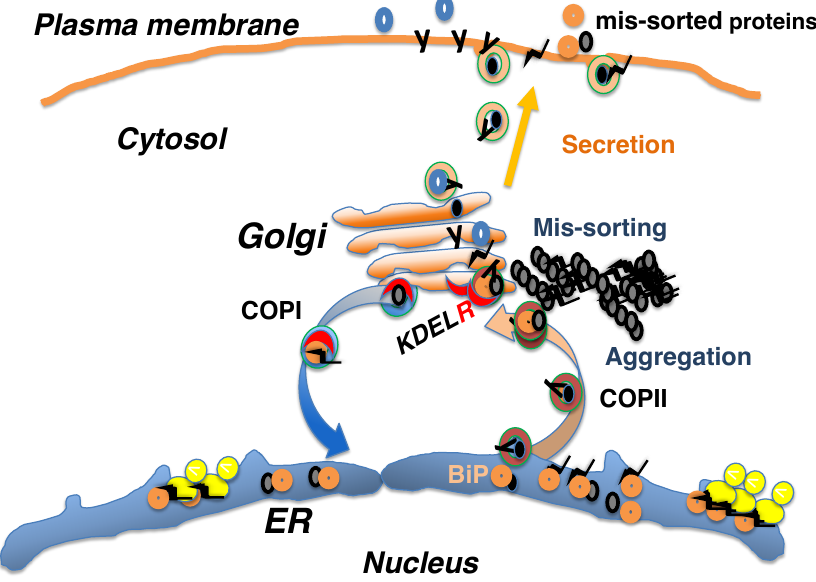
Figure 2. Some proteins, such as SP-C and reelin, require BiP retrieval by the KDEL receptor (KDELR) for proper folding in the early secretory pathway. Impaired retrieval by the KDEL receptor may result in defective proteostasis networks that a ff ect proper protein folding and degradation, leading to protein aggregation. Mis-sorting leads to the presence of immature and KDEL sequencing-containing proteins, such as BiP, on the plasma membrane, where they may perform atypical